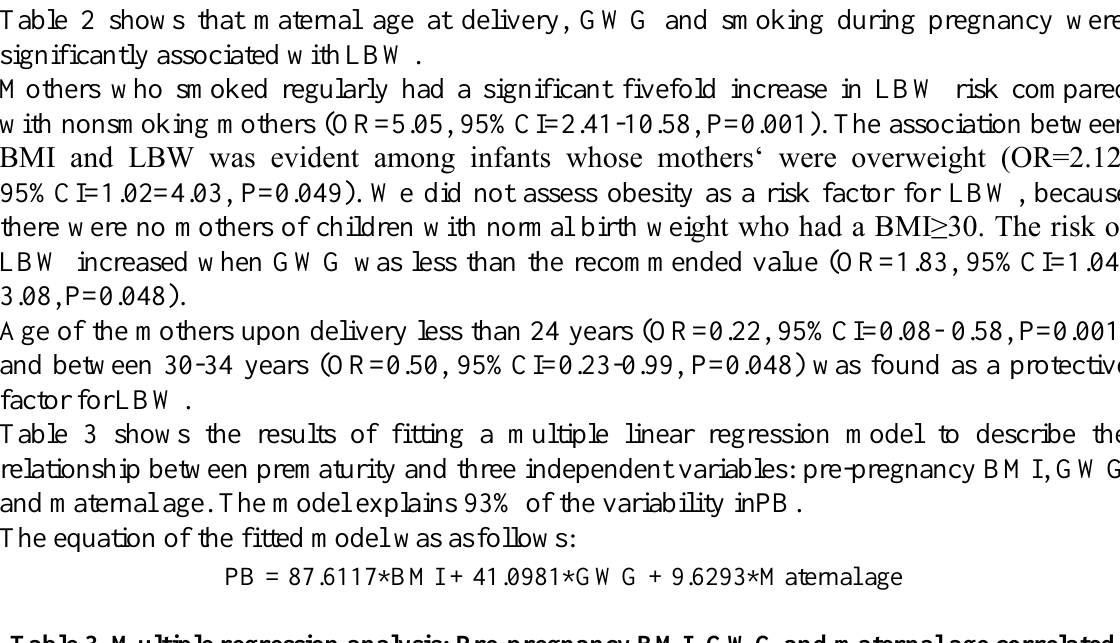
Table 3. Multiple regression analysis: Pre-pregnancy BMI, GWG and maternal age correlated with premature birth Dependent variable: premature birth Parameter Estimate